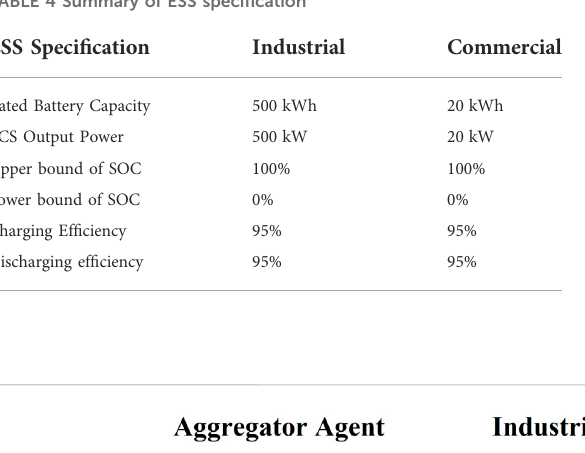
TABLE 4 Summary of ESS speci fi cation